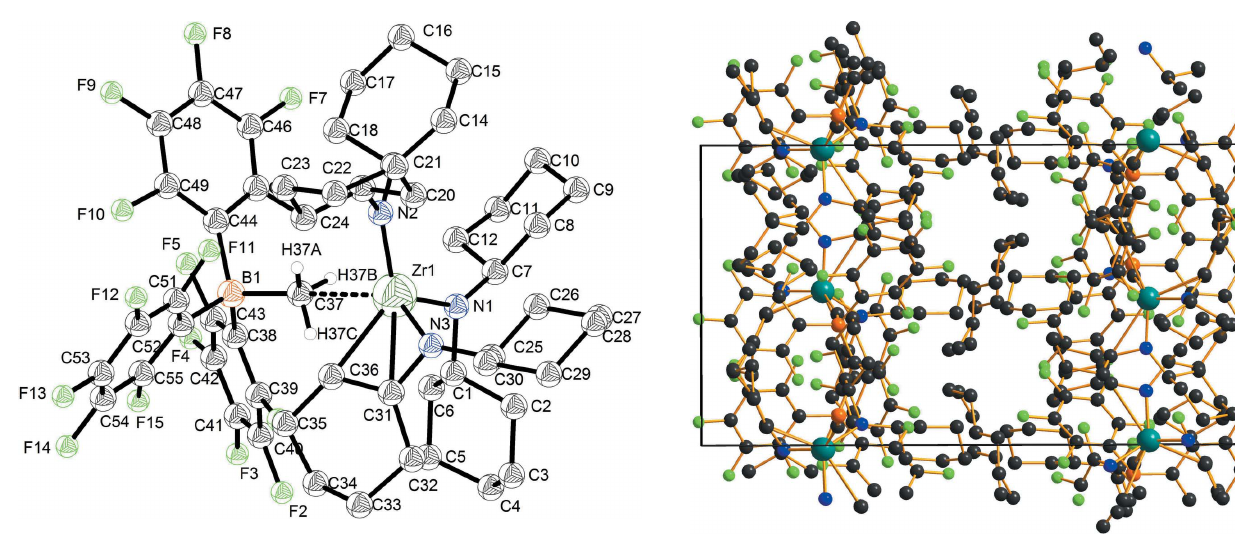
Figure 2 Solid-state molecular structure of complex 1 . Displacement ellipsoids correspond to the 50% probability level. H atoms except for those of the CH 3 group have been omitted for clarity.